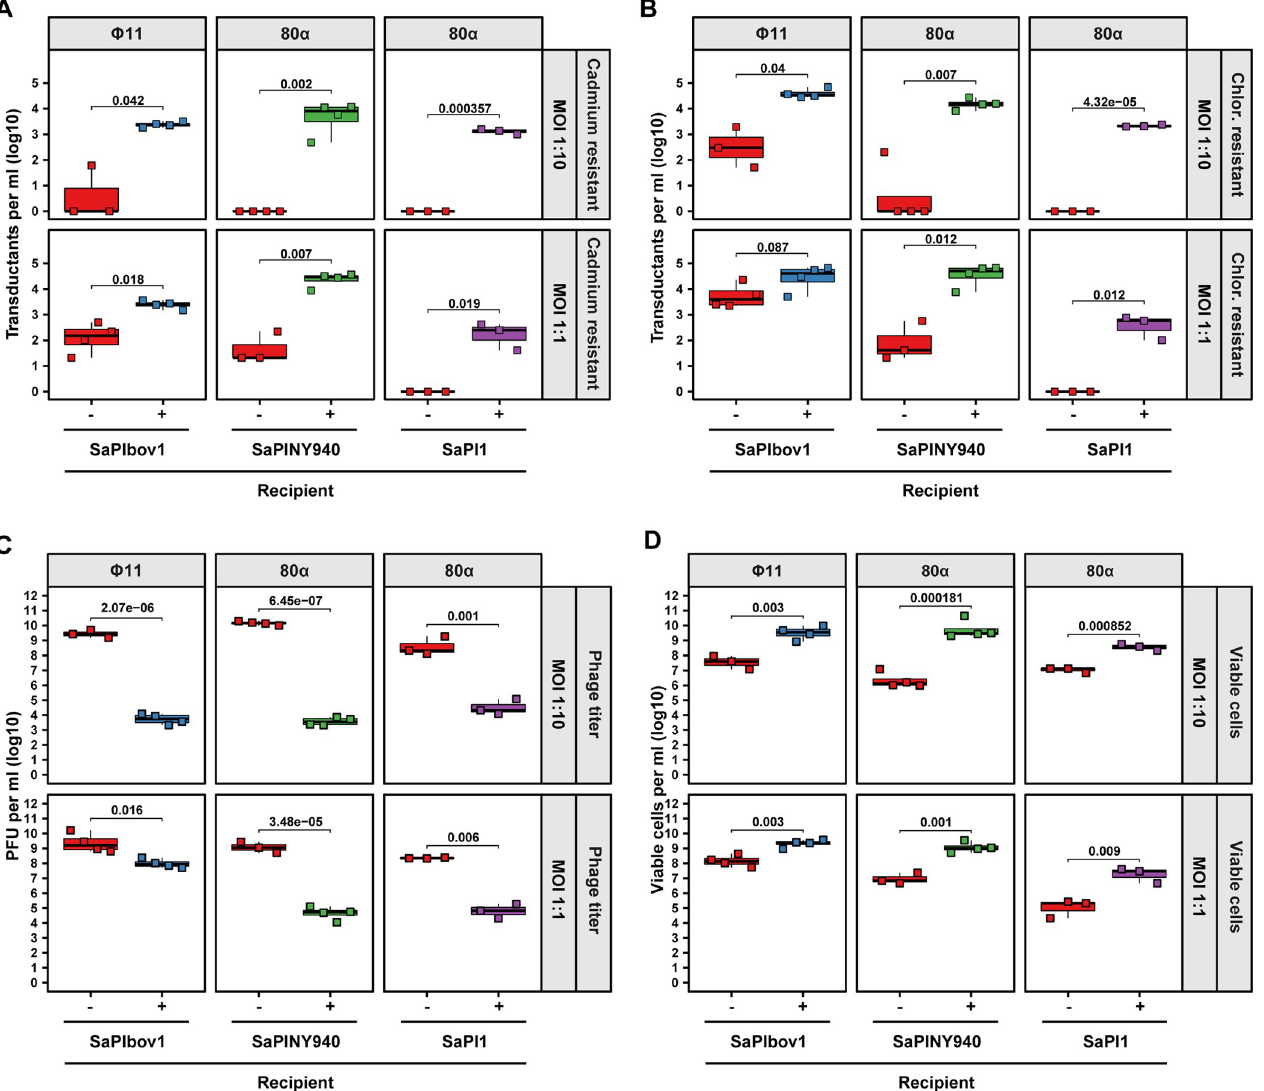
Fig 4. Impact of MOI on horizontal gene transfer, phage titers and viability. S . aureus RN4220 derivative strains either devoid of (red) or harboring either SaPIbov1 (blue), SaPINY940 (green) or SaPI1 (purple) were infected with an MOI of either 1:1 or 1:10 (phage:bacteria) of the indicated phages and acquisition of a chromosomal cadmium resistance marker (lateral transduction) (A) , a plasmid-borne chloramphenicol resistance cassette (generalized transduction) (B) , phage titers (C) and cell viability (D) was determined 18 h post-infection. Bold horizontal lines in each boxplot represent the median and lower and upper hinges the first and third quartiles, respectively (n = 3–4 biological replicates as indicated). Assessment of statistically significant differences between groups was performed using a two-sided Student’s t-test on log 10 transformed data. p-values are indicated above the respective comparison, ns not significant. Limit of detection (LOD) of transductants (A&B) is 10 transductants per ml, 100 plaques per ml for phage titers (C) , and 100 colonies per ml for viable cells (D) .